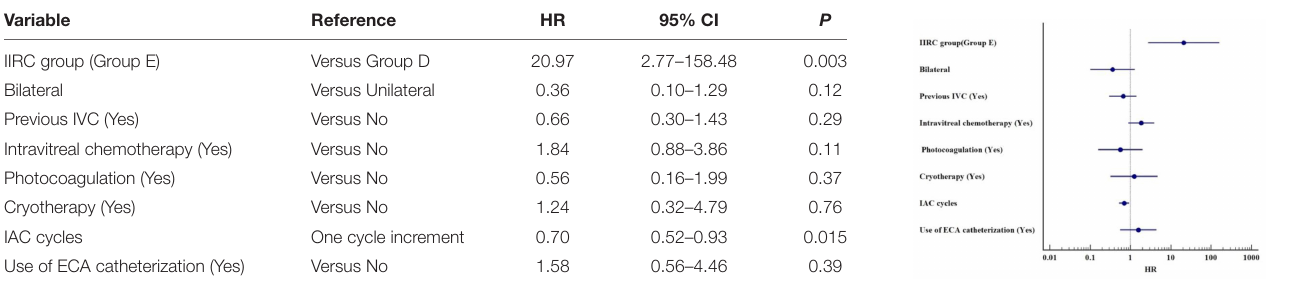
TABLE 3 | Multivariate Cox proportional hazards model for predicting